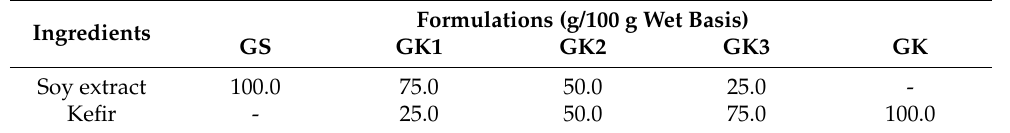
Table 1. Formulations with different concentrations of soy extract (GS) and soy kefir (GK) (g/100 g wet